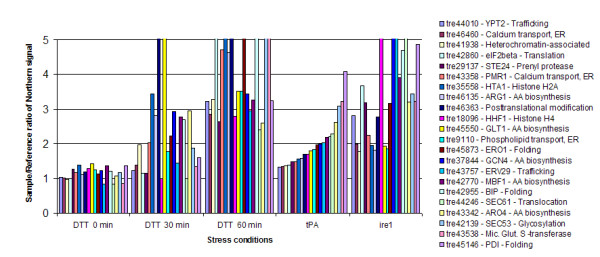
Northern analysis of selected T. reesei genes revealed by the cDNA subtraction library and cDNA-AFLP analysis. The expression level of the genes was analysed in cultures treated with DTT for 0, 30 and 60 min and in untreated reference cultures, in chemostat cultures of a tPA producing strain and its parental strain, and in a strain overexpressing ire1 and in its parental strain. The signals of the specific mRNAs were quantified and normalised using the signals of gpd1. The ratio of the signal in the analysed sample vs. the signal in a corresponding reference culture are shown for genes showing UPR-like gene expression. T. reesei protein model identifier (genome version 1.2), likely S. cerevisiae homologue and function or process in which the gene is involved is indicated after gene name. DTT 0 min, DTT treatment 0 min; DTT 30 min, DTT treatment 30 min; DTT 60 min, DTT treatment for 60 min; tPA, tPA producing chemostat culture; ire1, ire1 overexpressing strain.